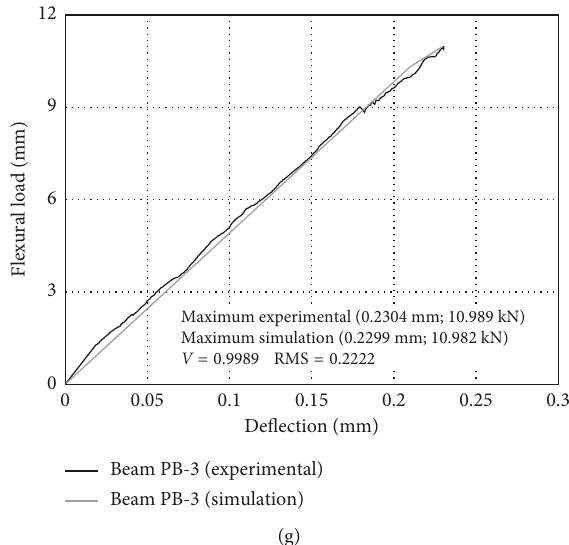
Figure 8: Experimental versus simulation load-deflection curve for series “P.” (a) Beam “P-0” (without fibres). (b) Beam “PP-1” (1% PVA fibres). (c) Beam “PB-1” (1% basalt fibres). (d) Beam “PP-2” (2% PVA fibres). (e) Beam “PB-2” (2% basalt fibres). (f) Beam “PP-3” (3% PVA fibres). (g) Beam “PB-3” (3% basalt